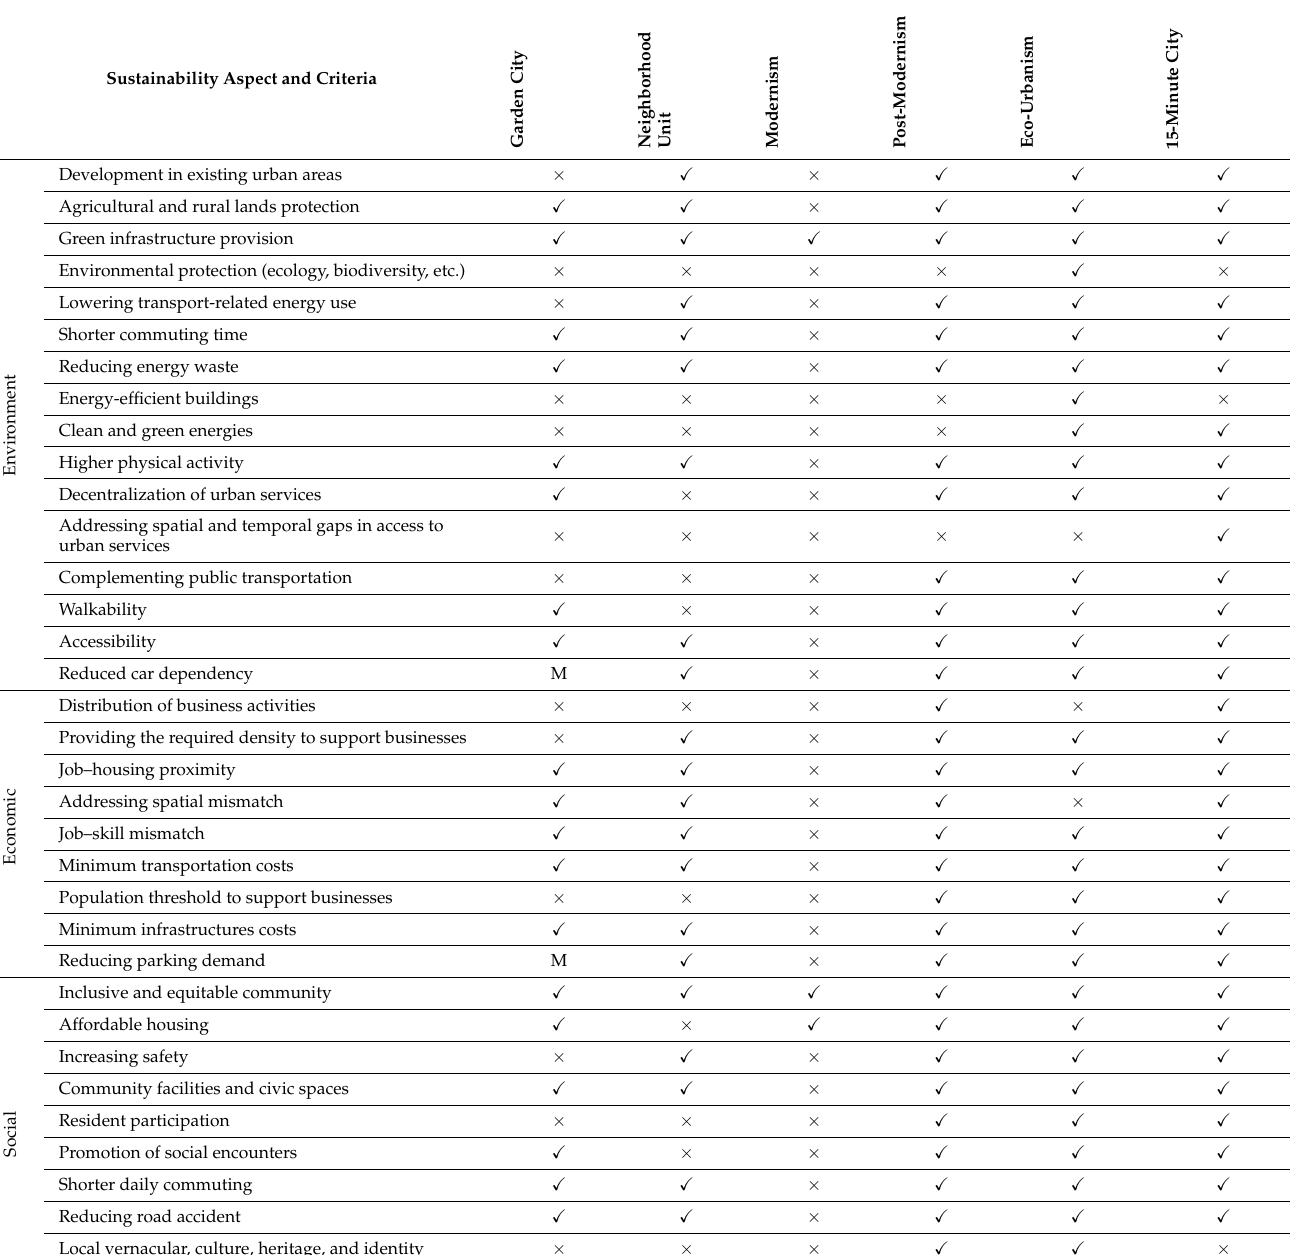
Table 2. Comparing different planning movements in terms of incorporating sustainability-related